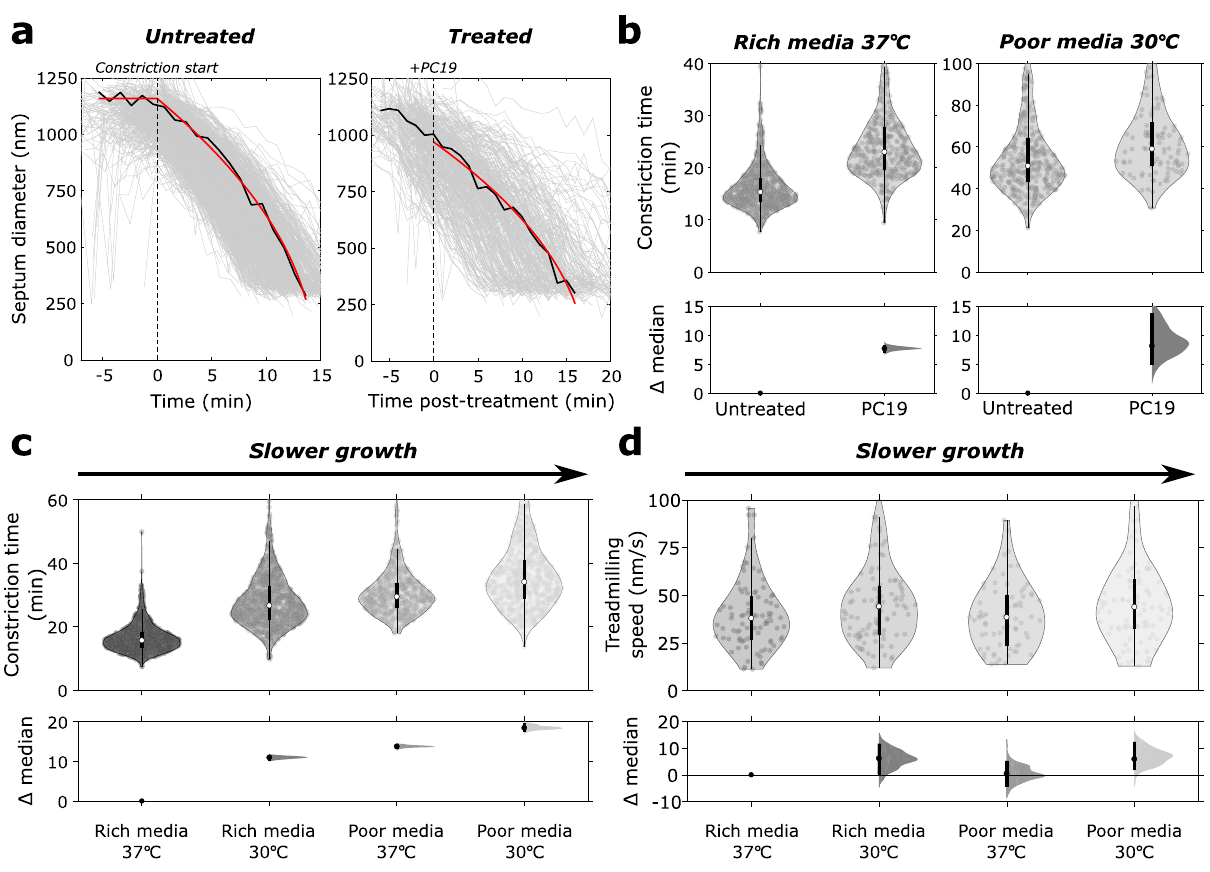
Fig. 4 Constriction rate is accelerated by FtsZ treadmilling and fast cell growth rate. a Time traces of ring diameters from mNeonGreen-PBP2B strain (ME7) for untreated (left) and PC19-treated (right) cells with constant PG synthesis model (red) fi tted to representative traces (black). Untreated cell trajectories are aligned relative to fi tted constriction start time (black dotted line on left panel). PC19-treated cell trajectories are aligned relative to the arrival time of PC19-laced media (black dotted line on right panel). b Constriction time before and after PC19 treatment for both fast growth (rich media 37 °C) and slow growth (poor media, 30 °C) conditions. c Constriction time of mNeonGreen-PBP2B cells in rich and poor media at two growth temperatures. d mNeonGreen-FtsZ (bWM4) treadmilling speeds in different media and temperature. Top panels, b – d : violin plots; white circle, sample median; thick black lines, interquartile range; thin black lines, 1.5x interquartile range. Bottom panels, b – d : Bottom panels: DABEST plots showing effect size analysis, compared to leftmost condition; black circles, median difference; error bars, 95% con fi dence interval of median difference. Source data for this fi gure are provided as a source data fi le.